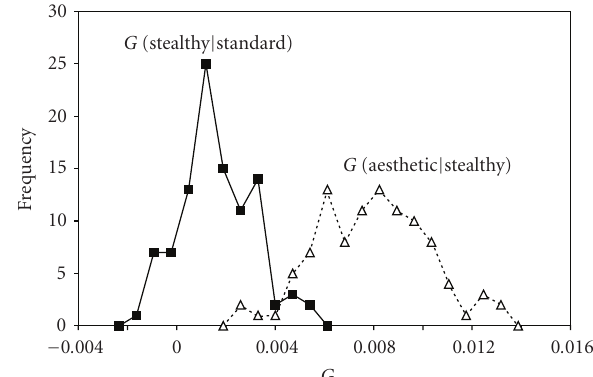
Figure 7: G ( P 1stealthy | P 0standard ) and G ( P 1aesthetic | P 0stealthy ) for γ = 10% .